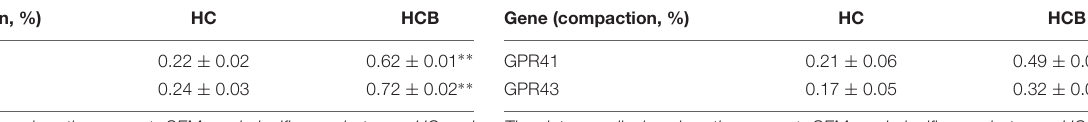
FIGURE 5 | Assessment of chromatin compaction and DNA methylation of GPR41 and GPR43 in the cecal mucosal tissue of lactating goats. “ HC group, “ (cid:78) ” represents the HCB group. (A,C) Correlations between chromatin compaction and DNA methylation of GPR41 and GPR43. (B,D) Correlations between chromatin compaction and mRNA expression of GPR41 and GPR43. R 2 is the correlation index, and P represents the significance of the correlation.